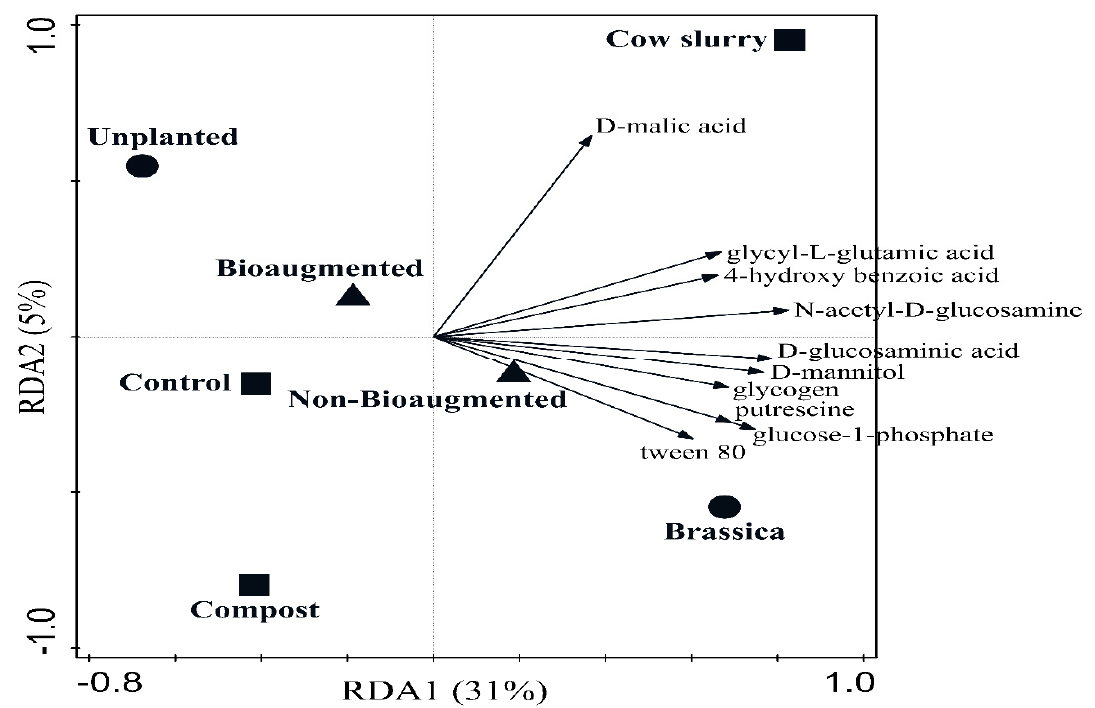
Figure 4. Biplot of the redundancy analysis (RDA) performed on the slopes calculated from Biolog EcoPlates TM growth curves. Units: 100 × absorbance units h − 1 . The 10 substrates that explained the highest percentage of the variability are shown. Compost: amended with composted horse manure; Cow slurry: amended with dried cow slurry.